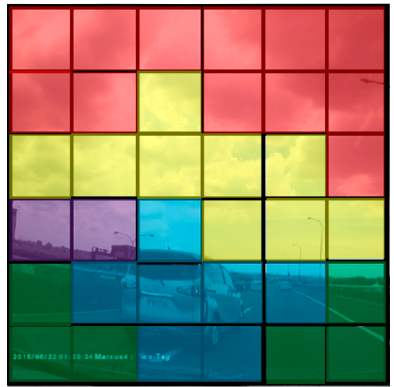
Figure 3. The probability map of specific classes.